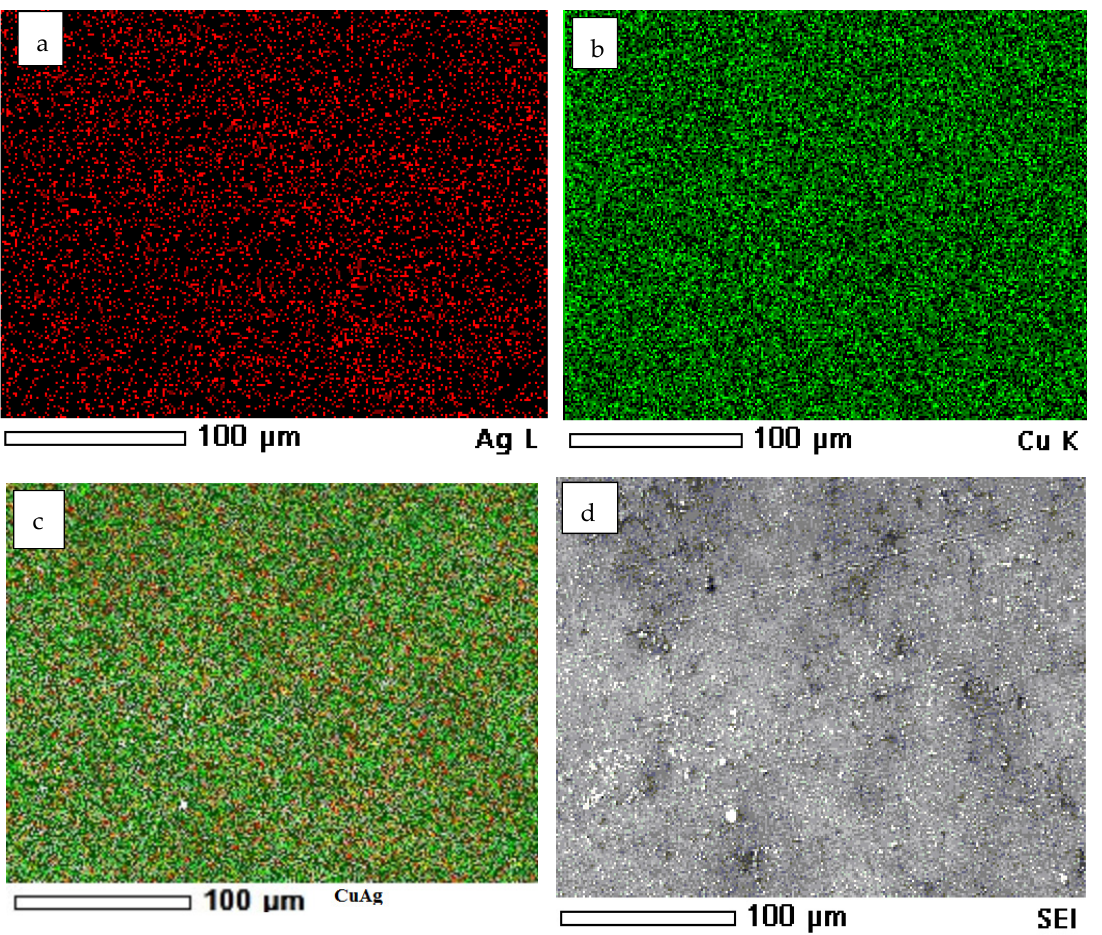
Figure 8. Mapping showing the distribution of the elements: ( a ) Ag; ( b ) Cu; ( c ) CuAg; and ( d ) original sample.